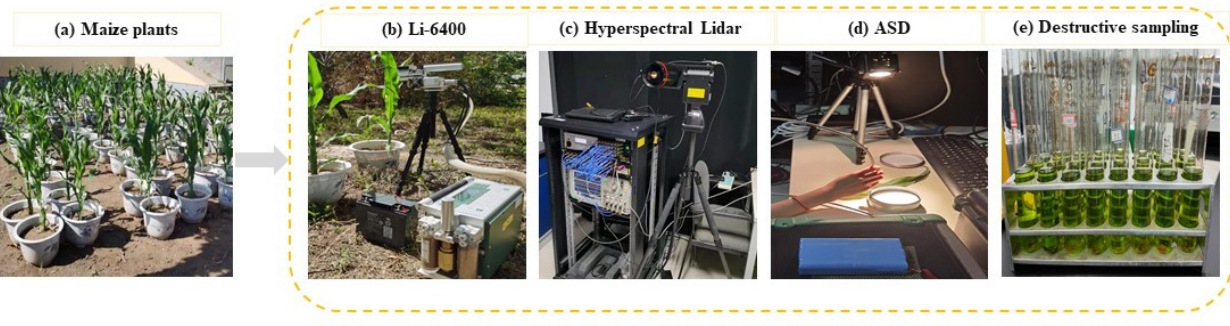
Figure 1. The data collection of ( a ) potted maize plants, ( b ) Li-6400 measurement, ( c ) HSL scanning, ( d ) ASD measurement, and ( e ) destructive sampling.